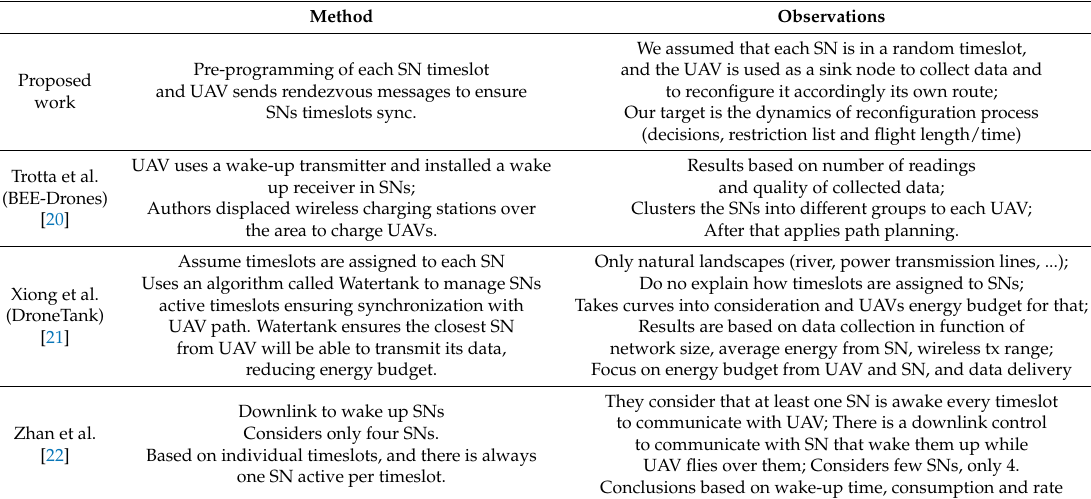
Table 2. Comparative methods from other